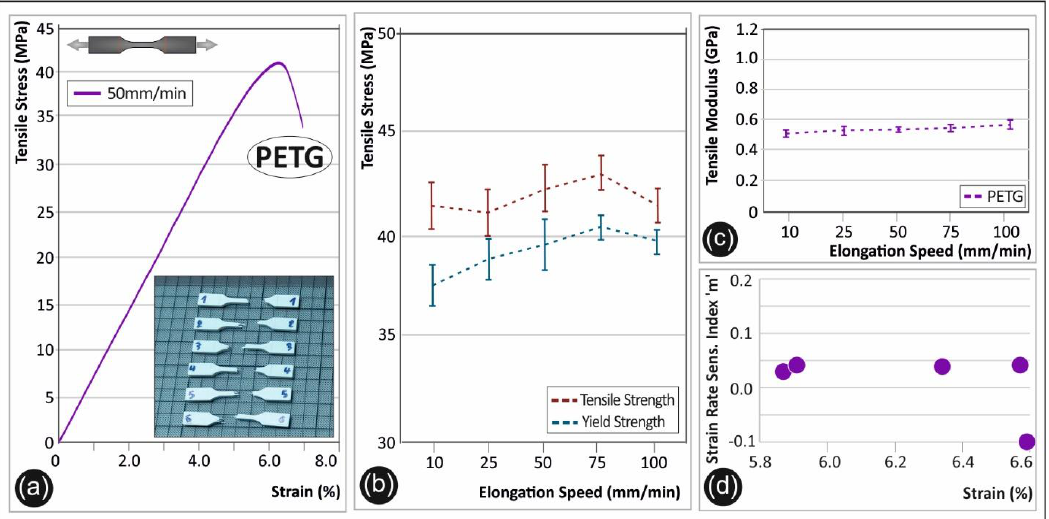
Figure 4. ( a ) Representative tensile stress (MPa)—strain (%) curve of polyethylene terephthalate glycol (PETG) at a 50 mm/min elongation speed, ( b ) average tensile strength and yield strength (with the corresponding standard deviation) for PETG in all five elongation speeds, ( c ) tensile modulus (with the corresponding standard deviation) of PETG under the five different elongation speeds, and ( d ) strain rate sensitivity index “m”—strain (%) graph for PETG.